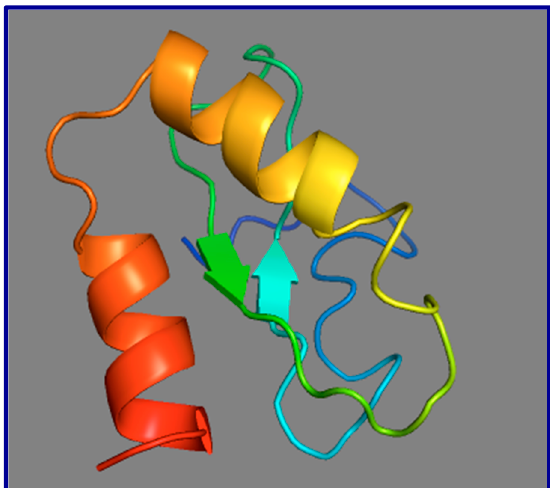
Figure 7. Model of the 3-dimensional structure of the human GAS5 73-residue smORFtide. This model was drawn as a prediction based on the conceptual translation of the human GAS5 smORF73, using I-TASSER (Iterative Threading ASSEmbly Refinement) at the ZhangLab website at the University of Michigan. Two strong α -helices are predicted encompassing MRIATEVLKS (orange-to-yellow shading) and HWHTGIRQKA (orange-to-red shading). Beta strands are indicated as flat arrows; the N-terminal 31-amino acids are unstructured (dark blue).